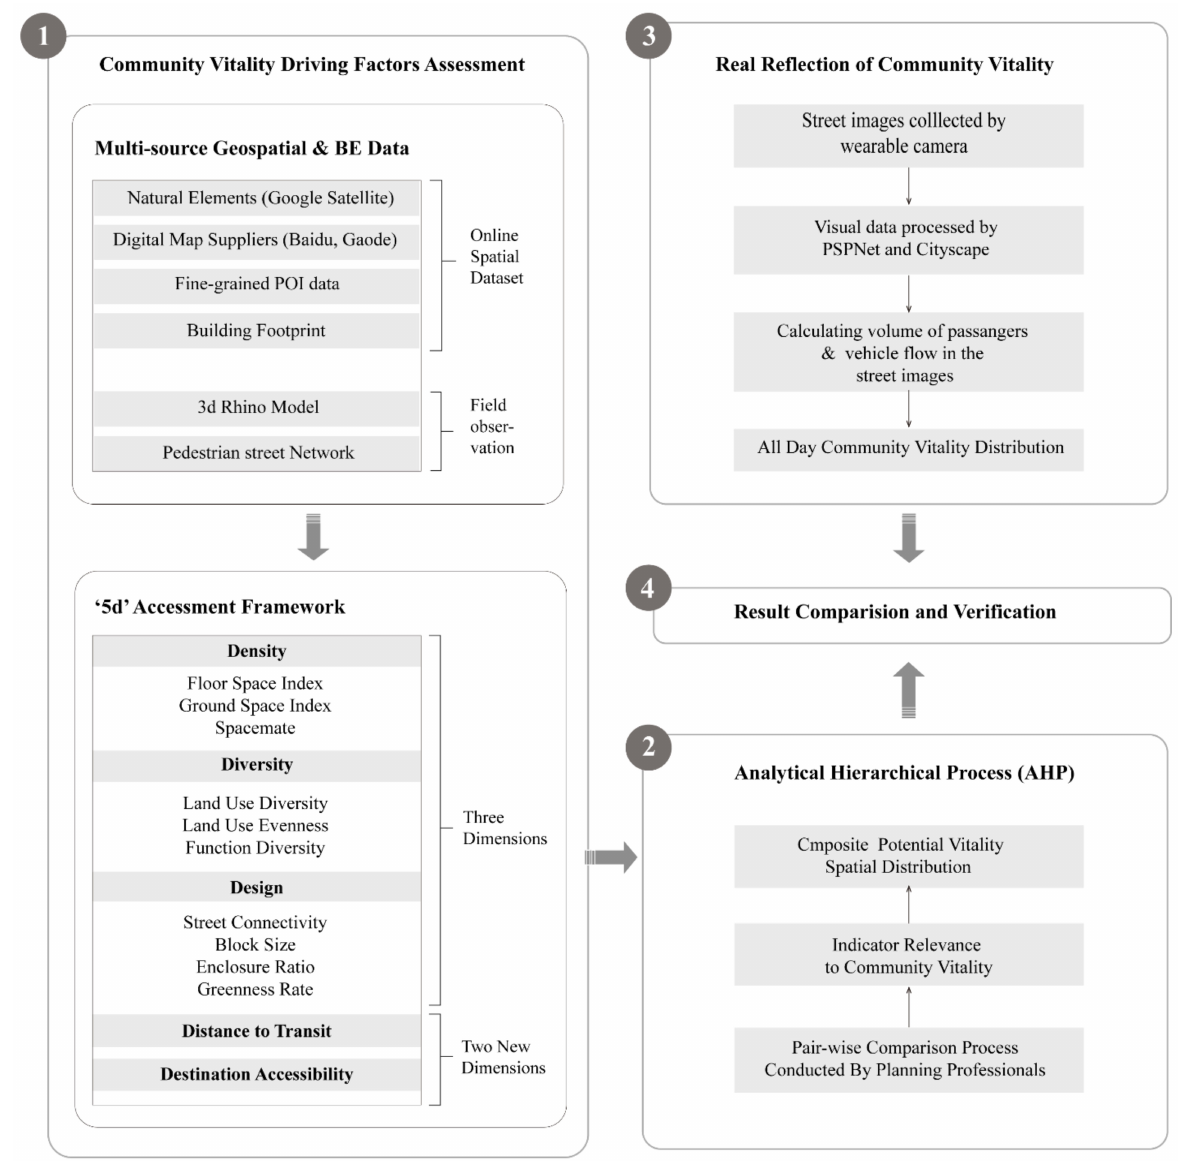
Figure 1. Conceptual framework of community vitality